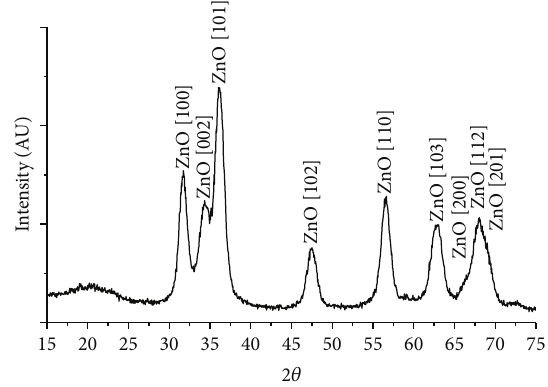
Figure 2: XRD results for ZnO